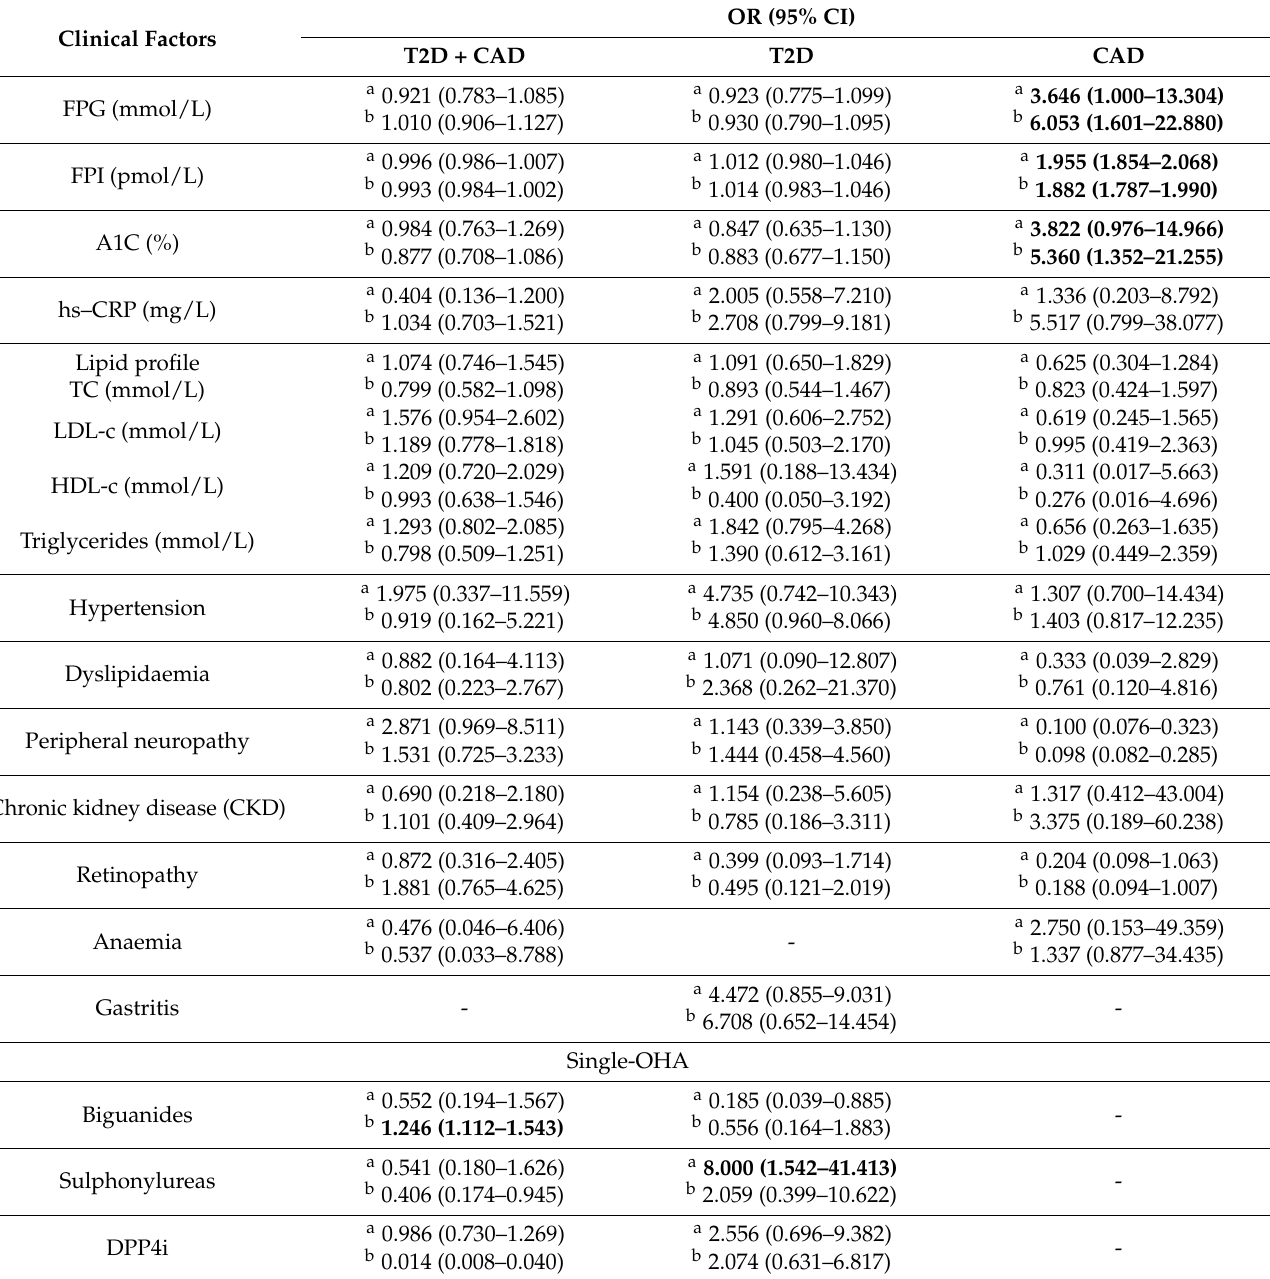
Table 3. Associations of clinical factors with rs17173608 in subjects ( n =